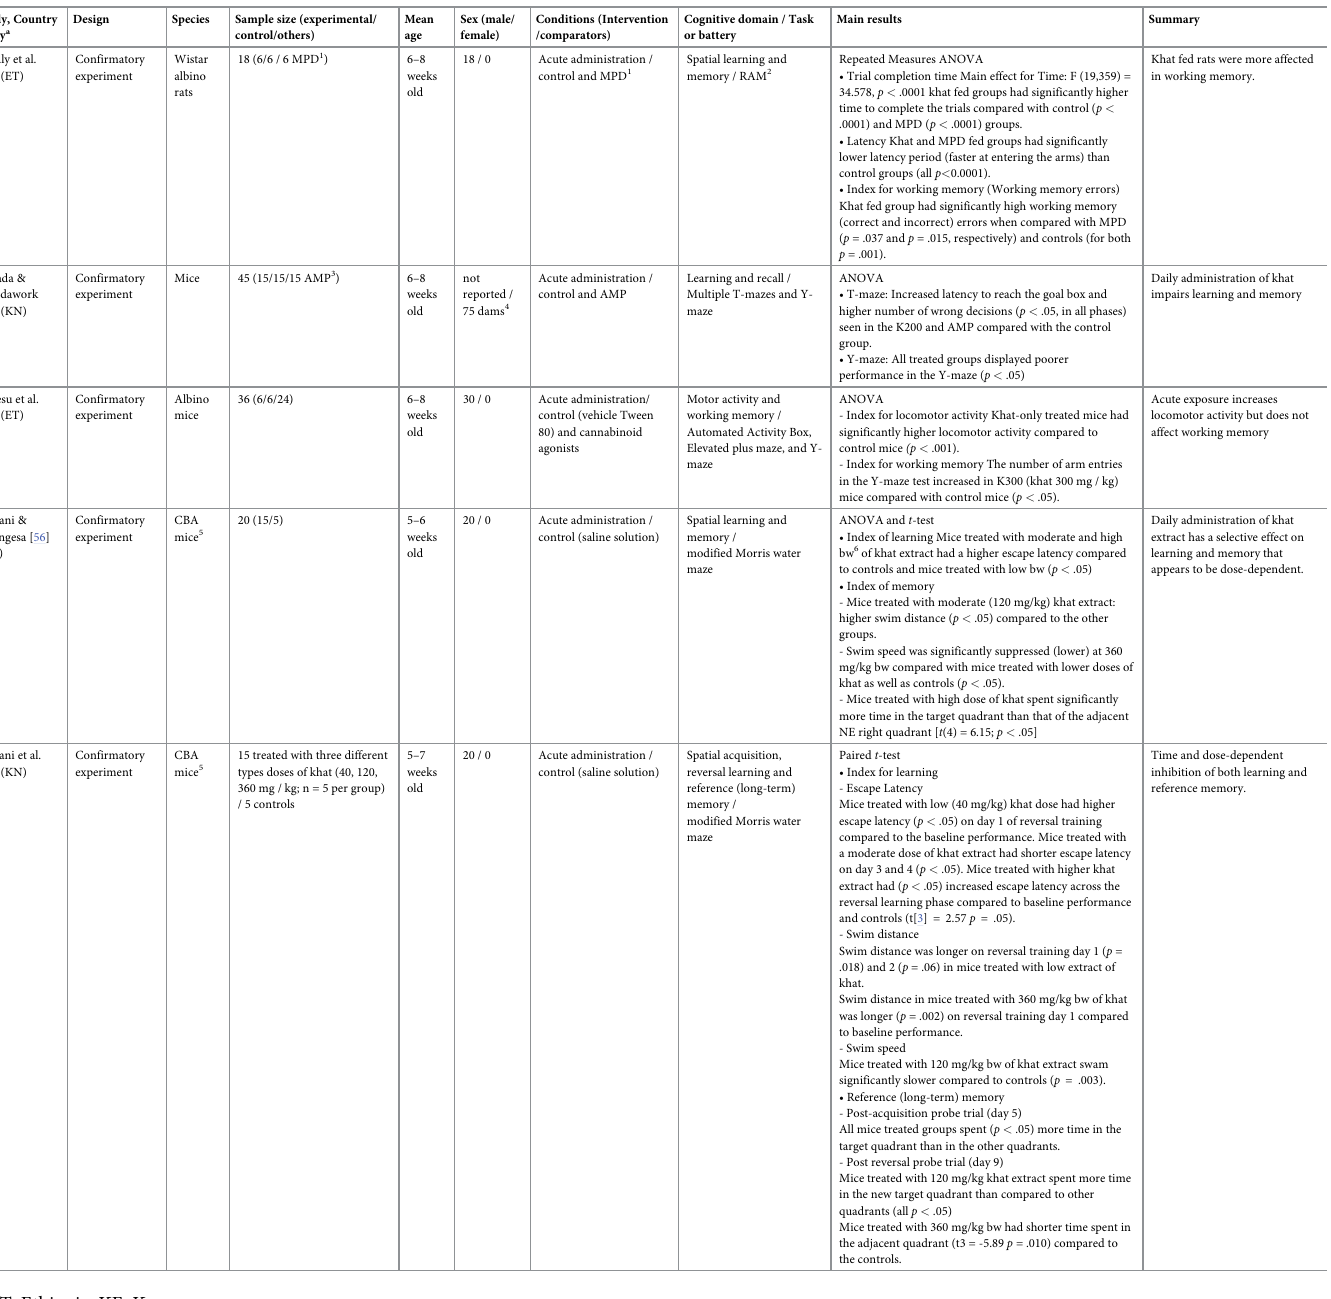
Dailyadministrationofkhat impairslearningandmemory